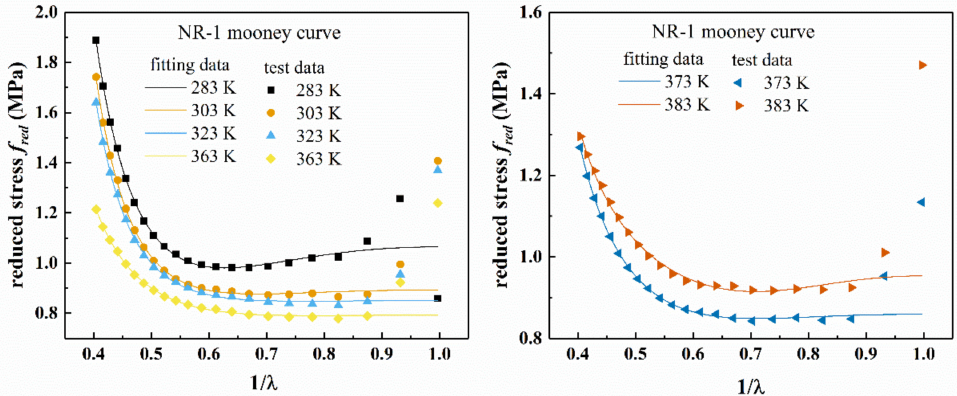
Figure 12. Mooney curves by improved eight-chain model for uniaxial tension of NR-1 at different